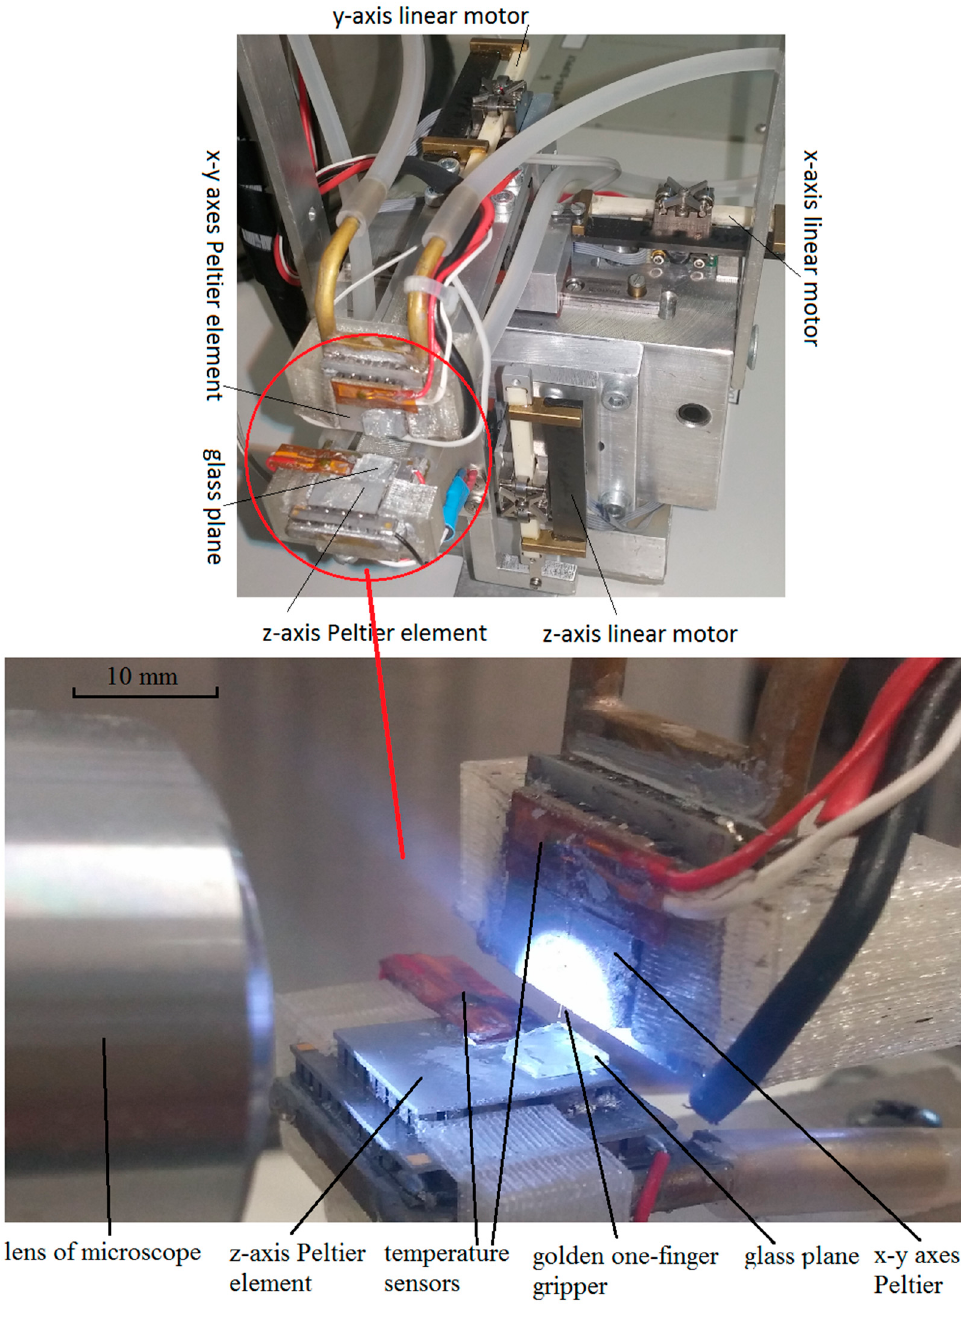
Figure 1. Nano-precision robotic system.